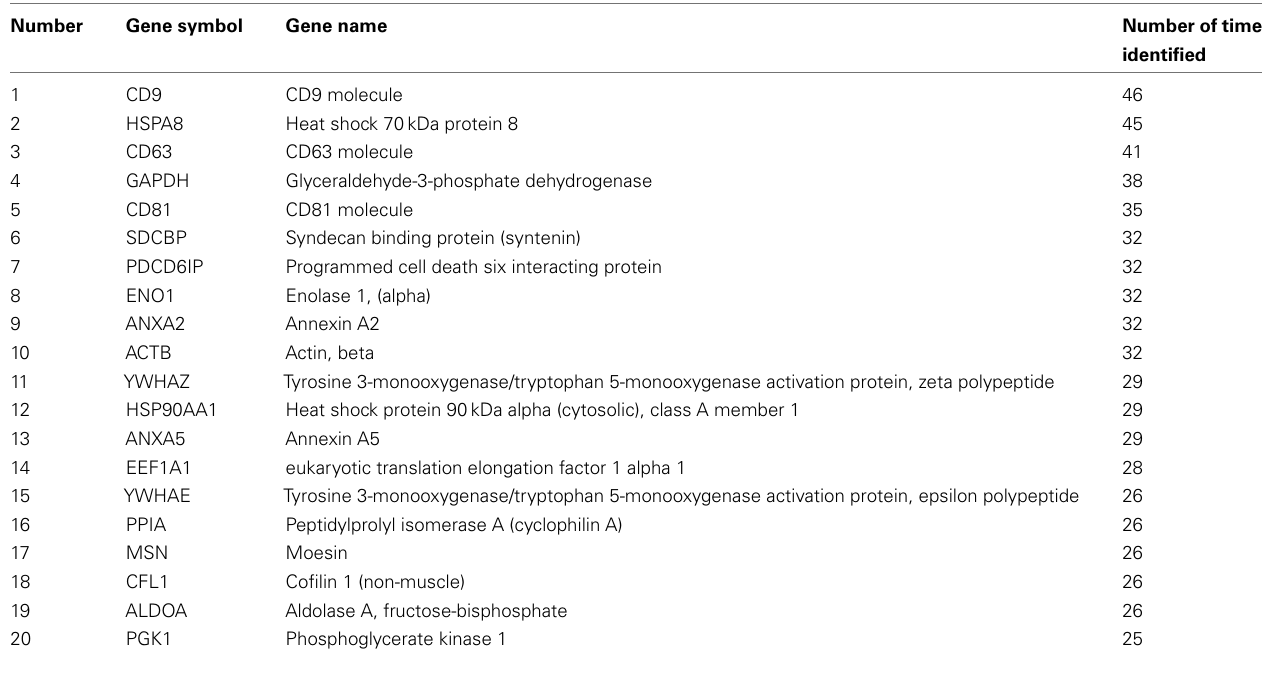
Table 2 | Proteins identified in exosomes as indicated in the ExoCarta